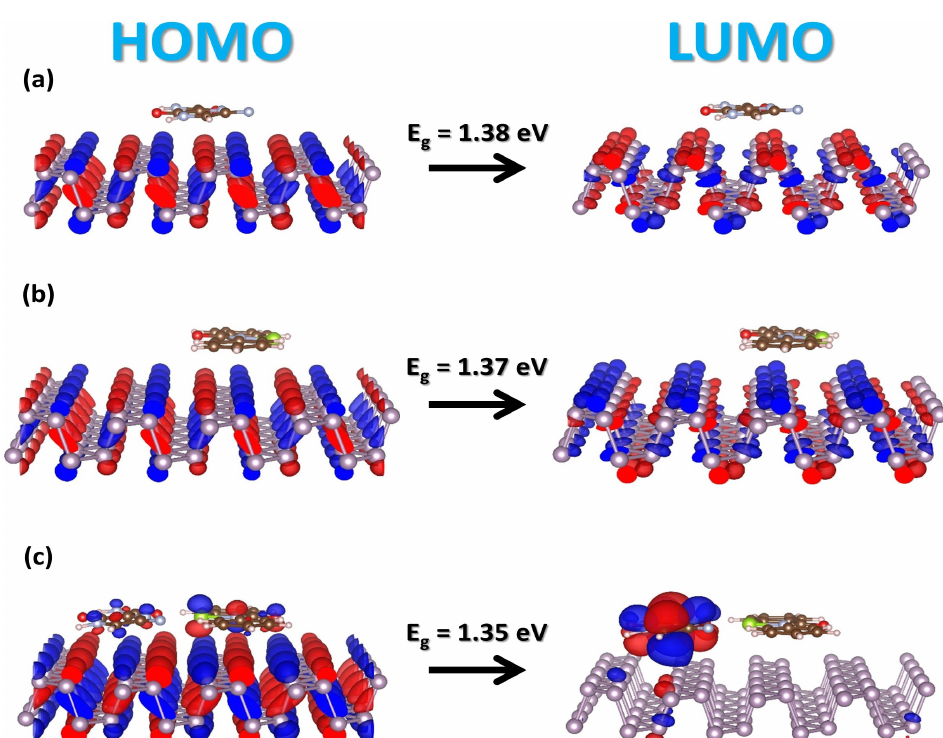
Figure 4. Three dimensional (3D)–view of the highest occupied (HOMO) and lowest unoccupied (LUMO) orbitals, and energy gap of ( a ) favipiravir, ( b ) ebselen, and ( c ) hybrid molecules on black phosphorus. The red and blue colors represent isosurface electron accumulation and depletion ( ρ = ±3.5 × 10 − 4 ¯e/Å 3 ), respectively.